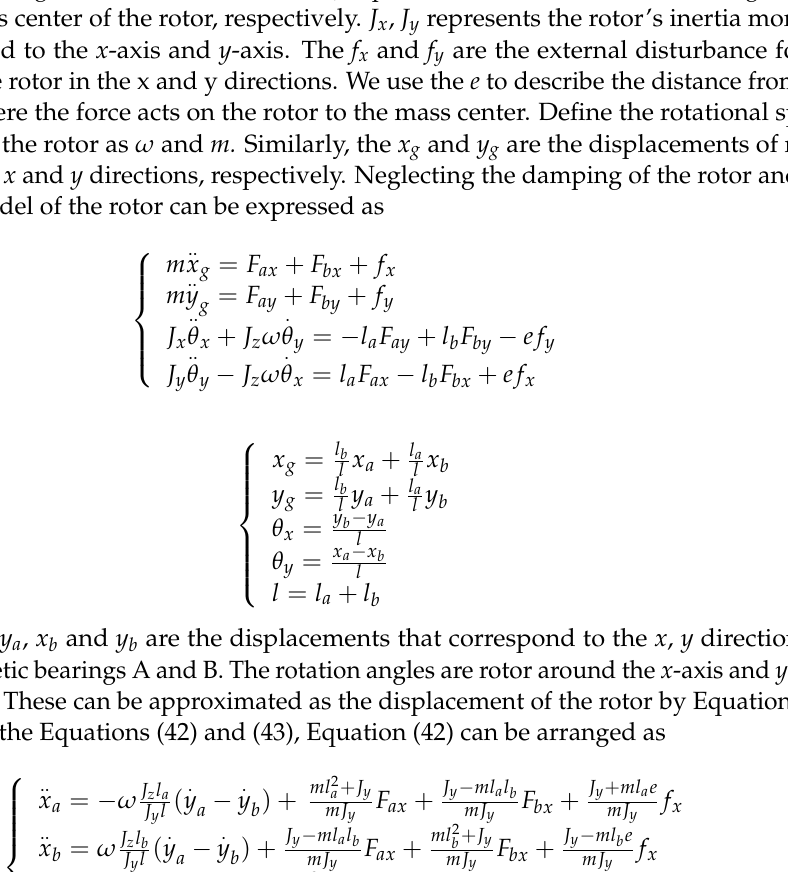
Figure 9. Dynamics of the magnetically-levitated rotor.